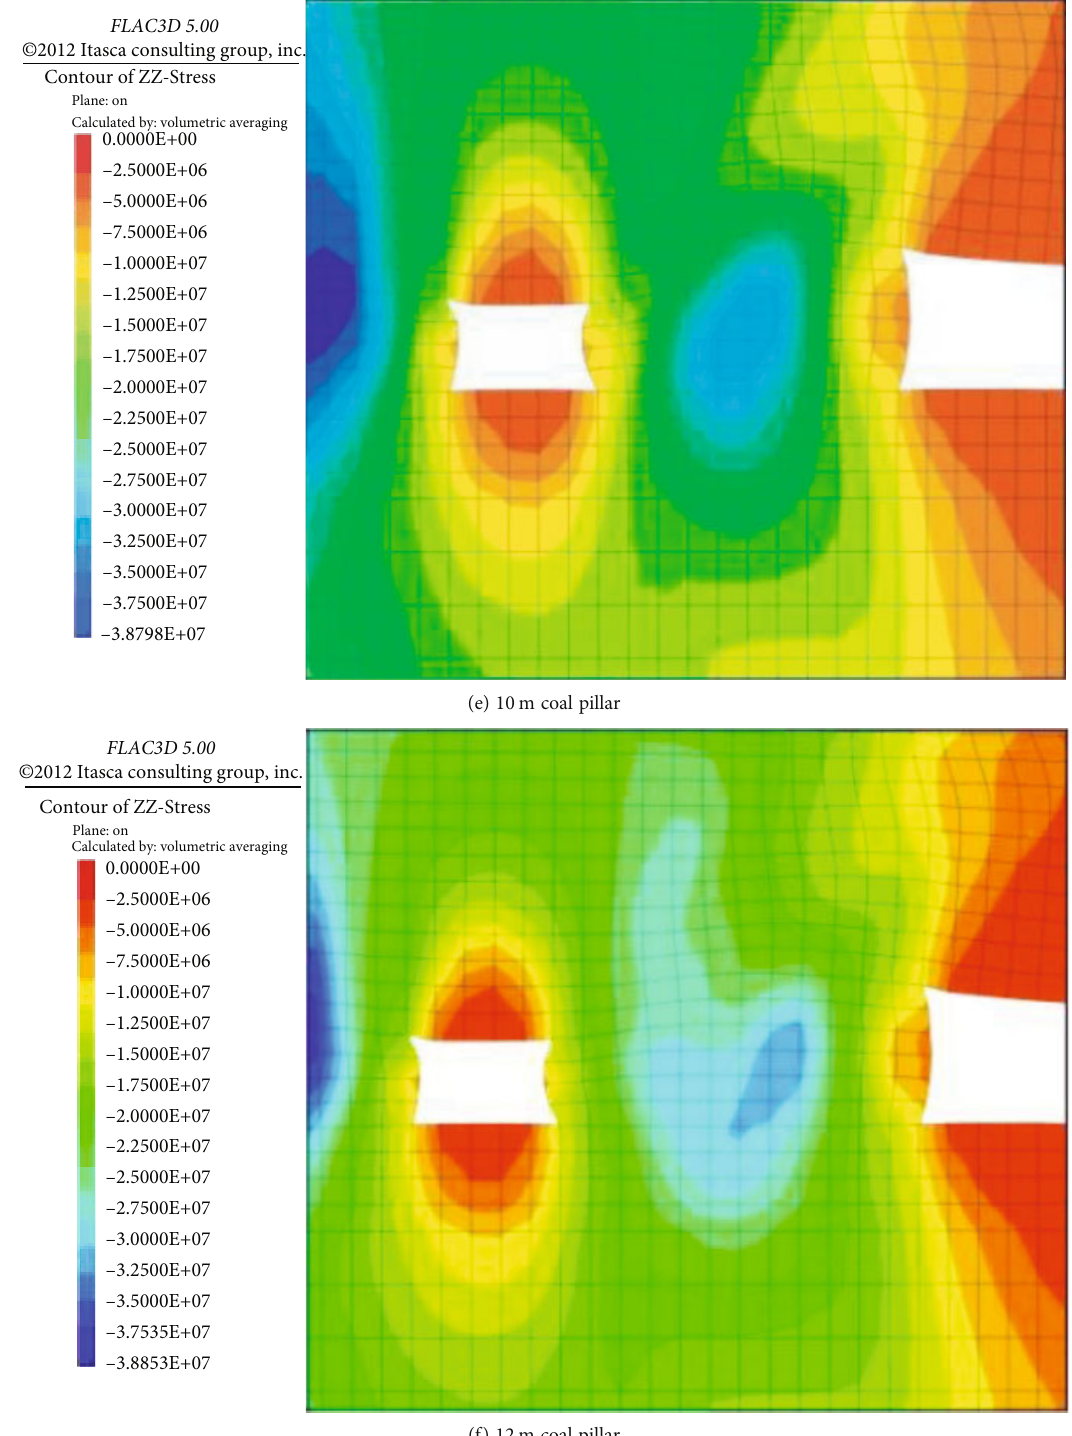
Figure 7: Cloud map of vertical stress distribution of di ff erent coal pillar widths under the e ff ect of one